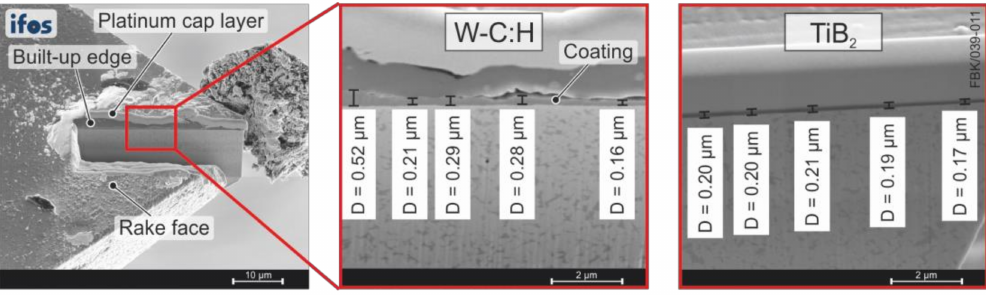
Figure 6. FIB cut at the tip of the micro end mill, coated with W-C:H ( middle ) and TiB 2 ( right